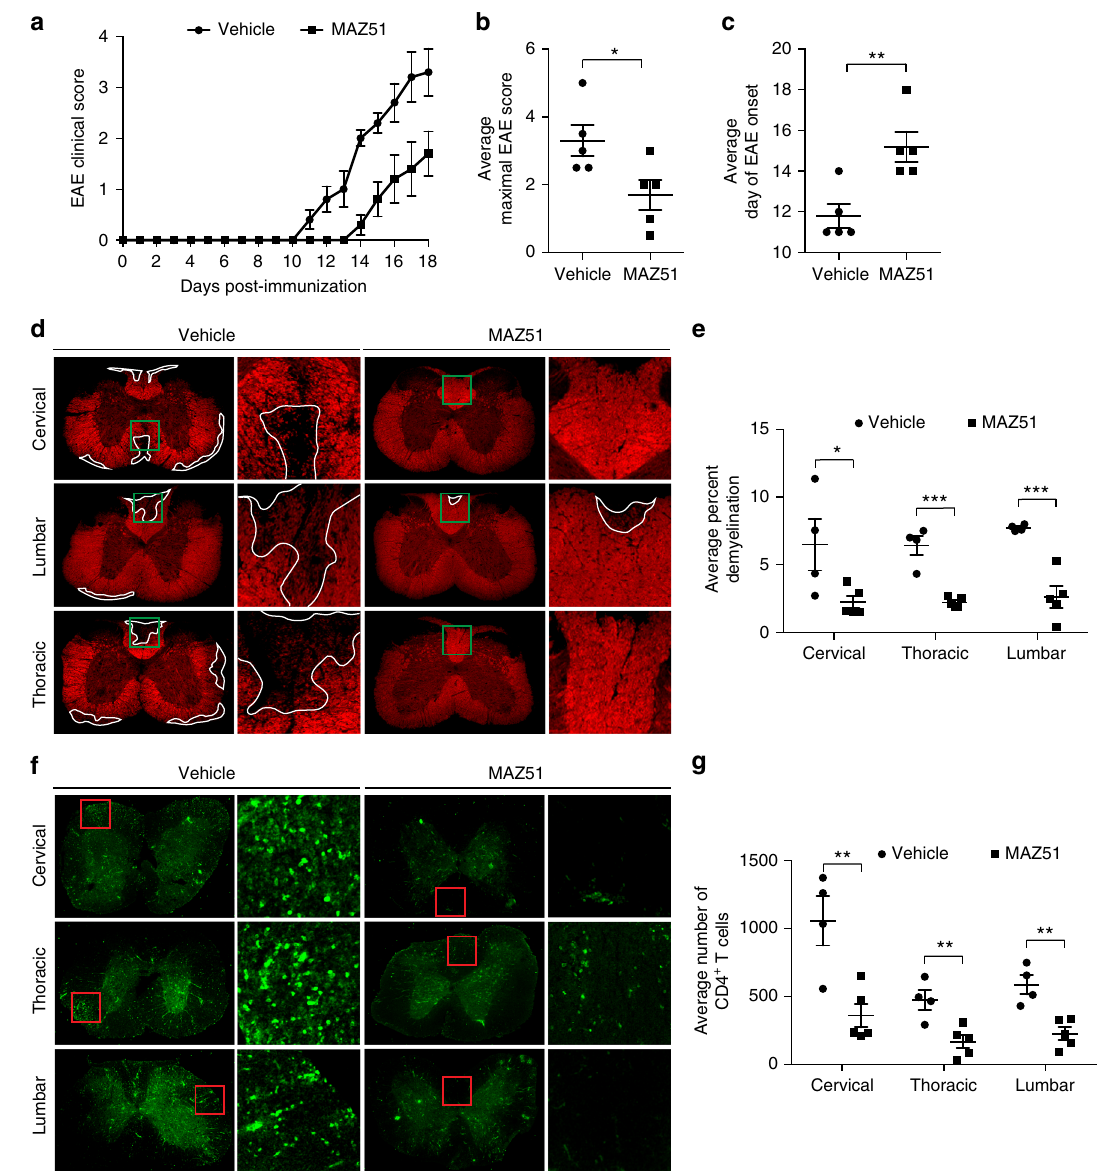
Fig. 7 Inhibition of VEGFR3 reduces EAE severity. a – c ß-gal fl oxed ovalbumin peptides (OP) transgenic mice were crossed with an oligodendrocyte-speci fi c Cre mouse (CNP-Cre) to generate CNP-OP transgenic mice. EAE was induced in CNP-OVA mice, treated with either vehicle or MAZ51, and were adoptively transferred CellTrace Violet labeled, Thy1.1 congenic, CD8 (OT-I), and CD4 (OT-II) T cells as shown in Fig. 5. EAE severity of mice receiving I.P. MAZ51 once per day beginning on day 7 post-immunization have reduced EAE severity ( a ), reduced average maximal EAE scores ( b ) ( n = 5 mice per group; data are represented as mean ± SEM, * p < 0.05, unpaired Student ’ s t -test), and delay in the EAE onset ( c ) ( n = 5 mice per group; data are represented as mean ± SEM, ** p < 0.01, unpaired Student ’ s t -test). d , e The spinal cords of MAZ51 and vehicle treated animals were immunolabeled with Fluoromyelin to visualize myelin within the spinal cord ( d ). MAZ51-treated mice have signi fi cantly reduced percent demyelination when compared to vehicle-treated controls ( e ) ( n = 4 – 5 mice per group; data are represented as mean ± SEM, * p < 0.05, *** p < 0.001, two-way ANOVA with Sidaks